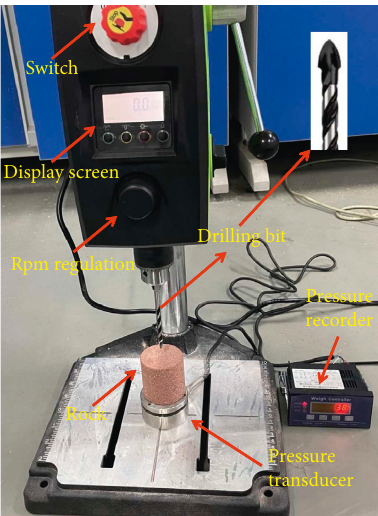
Figure 3: Rock drilling test device.